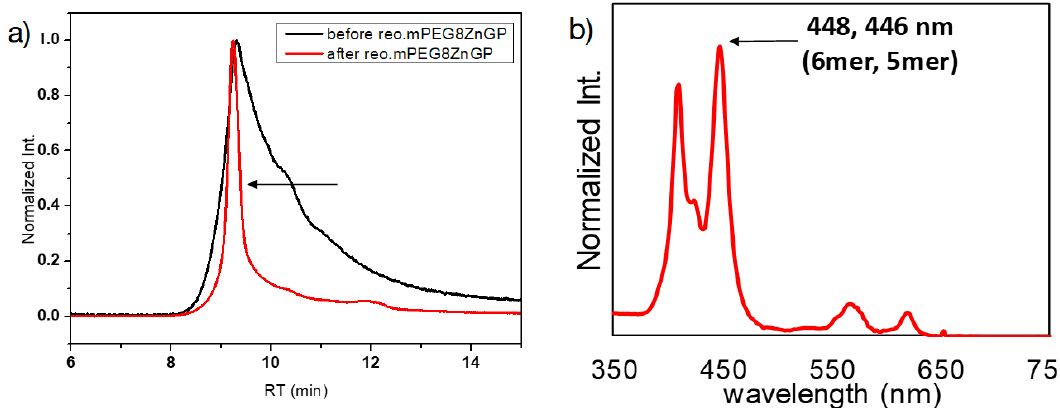
Figure 14. ( a ) GPC charts of (black) before and (red) after reorganization of PEG8-GP1 . (column; TOSOH TSKgel G4000H HR (exclusion limit; 400 kDa), eluent; CHCl 3 :THF=95:5, flow rate; 1.0 mL/min, detection; 565 nm) ( b ) UV-vis spectra obtained on PDA detector at retention time (RT) 9.1 min in the GPC after reorganization. In this Figure, characteristic Soret bands, 448 and 446 nm, corresponding to 6mer and 5mer are overlapped, and they are difficult to be distinguished.